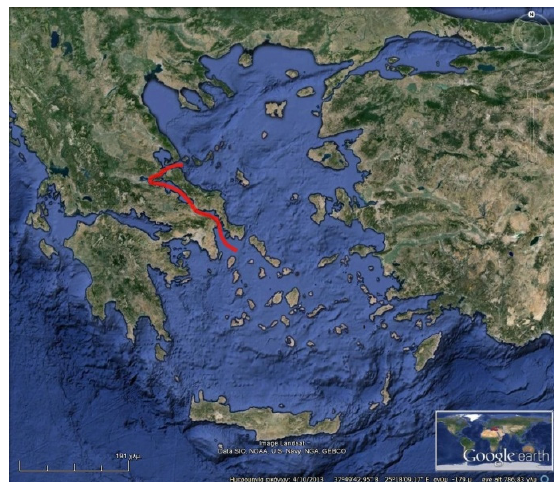
Figure 1: Sea route through the Euboean